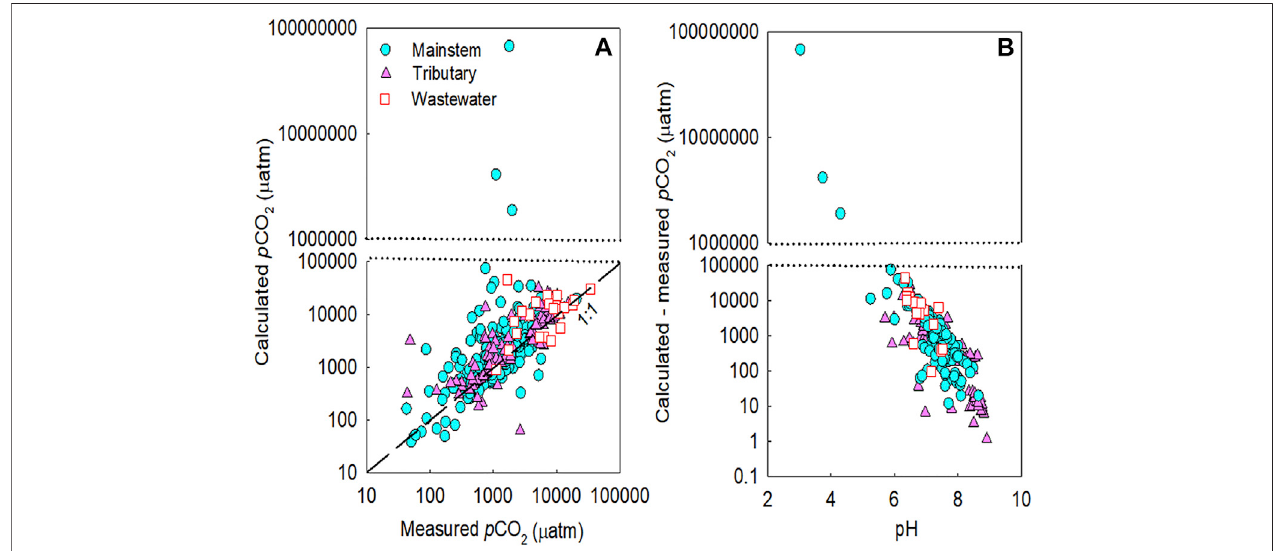
FIGURE 2 | Comparison of the measured and calculated partial pressure of CO 2 ( p CO 2 ) (A) and the difference between calculated and measured p CO 2 as a function of pH (B) in the mainstems (M), tributaries (T), and polluted urban tributaries or wastewater ef fl uents (W) of the fi ve studied river basins across Asia. The studied rivers include the Ganges, Mekong, Yangtze, Yellow, and Han River. The dashed black line represents the 1:1 line.